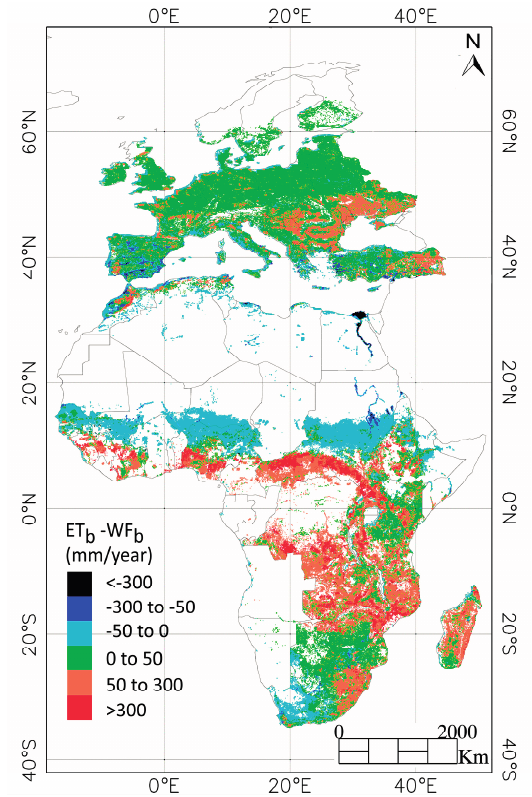
Figure 9. Difference between ET Mekonnen and Hoekstra